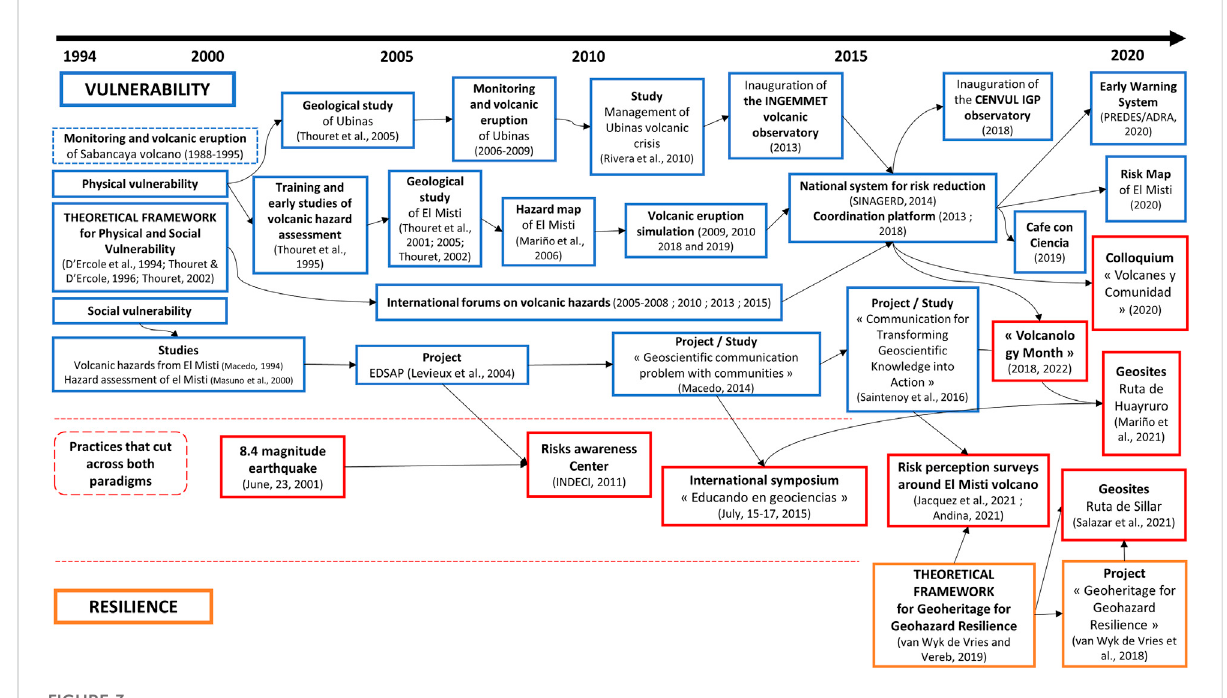
FIGURE 3 Genealogical map of the practices between vulnerability and resilience in Arequipa (1994 — 2020).